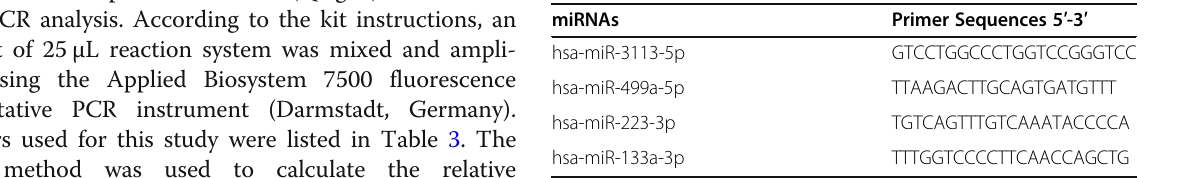
Table 3 Primer sequences used in this